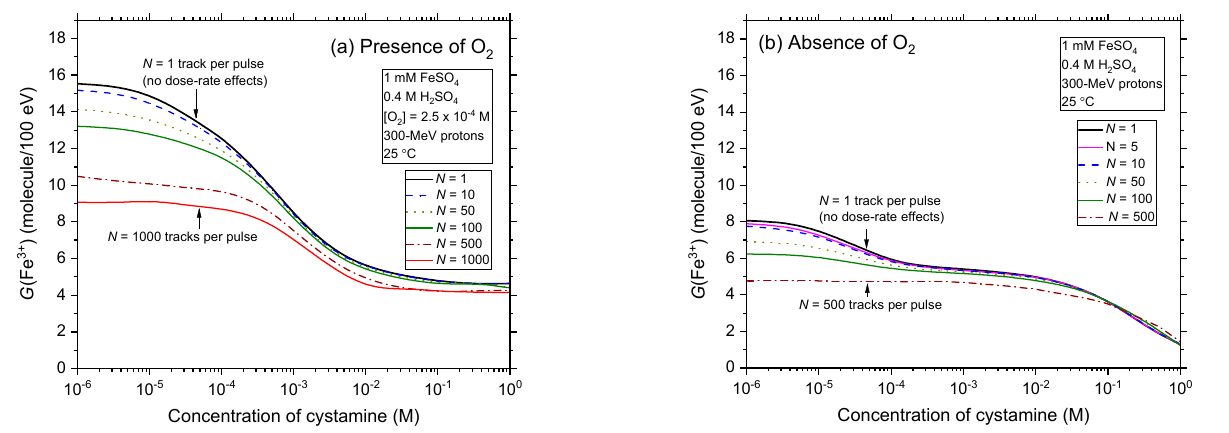
Figure 5. Dependence of Fe 3+ ion production from irradiated Fricke-cystamine solutions upon the concentration of added cystamine in the range from 10 − 6 to 1 M for different values of N under aerated (panel ( a )) and deaerated (panel ( b )) conditions. Data for N = 1 (absence of dose-rate effects) are used as a reference. As before, for the sake of clarity, we only show here the curves for N = 1, 10, 50, 100, 500, and 1000.